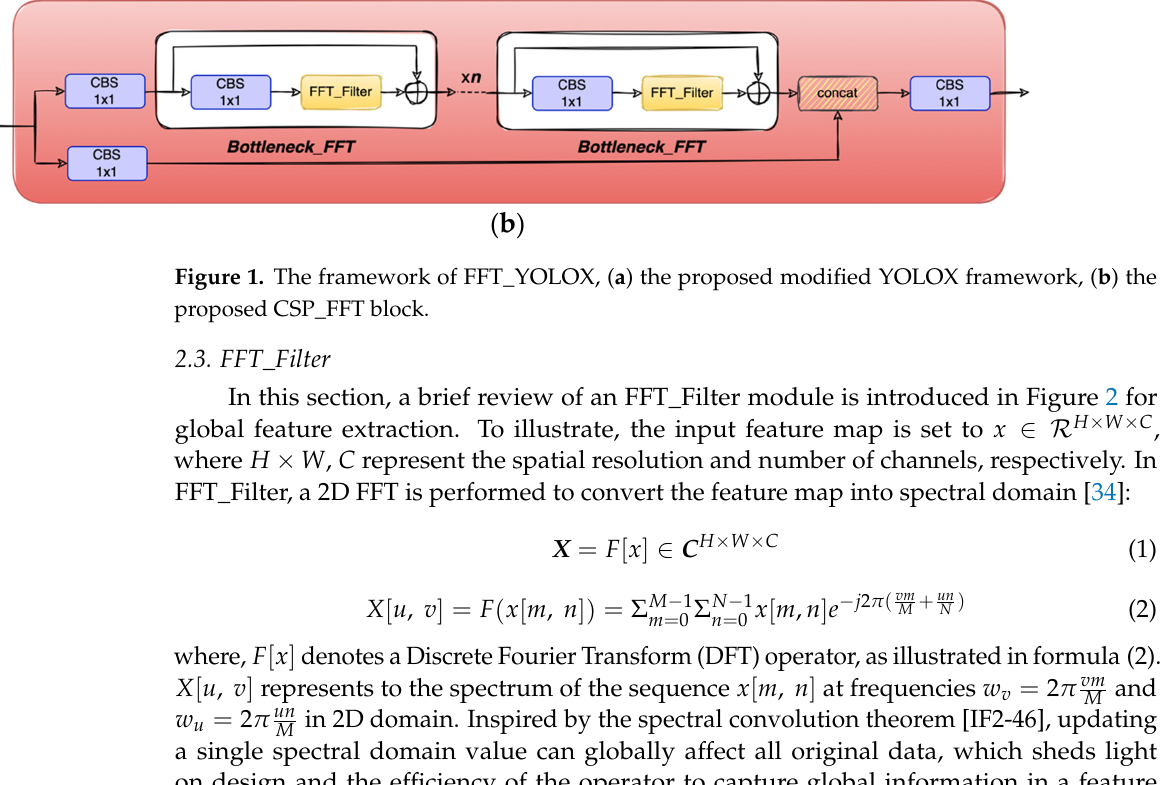
Figure 2. The architecture of FFT_filter.